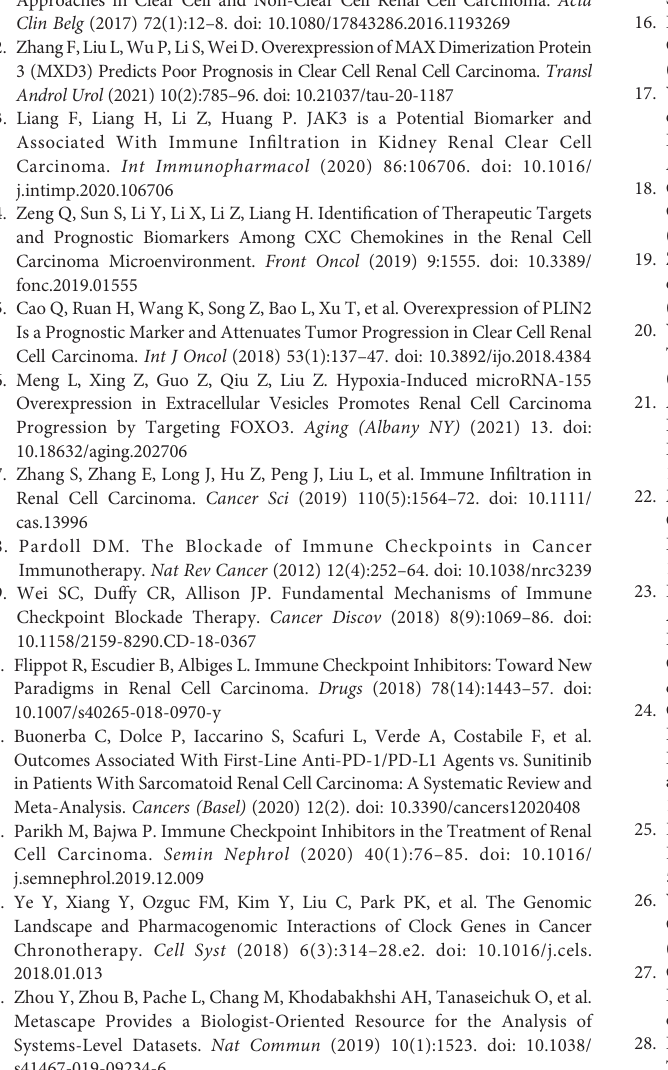
Supplementary Figure 1 | The mRNA level of immune checkpoints in KIRC (Oncomine). The graph shows the numbers of datasets with statistically signi fi cant mRNA over-expression (red) ordown-regulated expression (blue) of the target gene with a p-value of 0.05 and fold change of 2. Supplementary Figure 2 | The functional analysis of immune checkpoints in KIRC. (A) HeatmapofGOandKEGGenrichedterms. (B) Protein-proteininteraction network of immune checkpoints networks. Supplementary Figure 3 | The progression free survival analysis of immune checkpoints in KIRC. (A) The progression free survival curve of CTLA4 in KIRC patients with high and low CTLA4 expression, and the risk score, survival status and gene expression of each patients, as well as time-dependent ROC. (B) The progression free survival curve of HAVCR2 in KIRC patients with high and low HAVCR2 expression, and the risk score, survival status and gene expression of each patients, as well as time-dependent ROC. (C) The